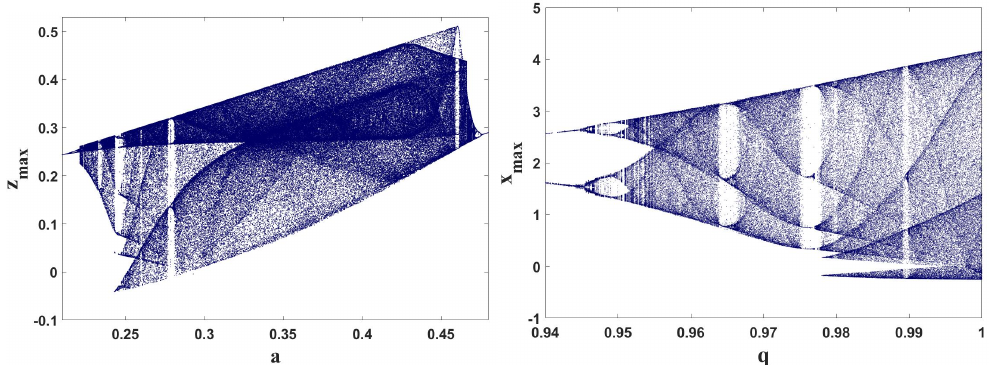
Figure 4. One parameter bifurcation diagram for z max as a function of a (left plot) and x max as a function of fractional order q (right